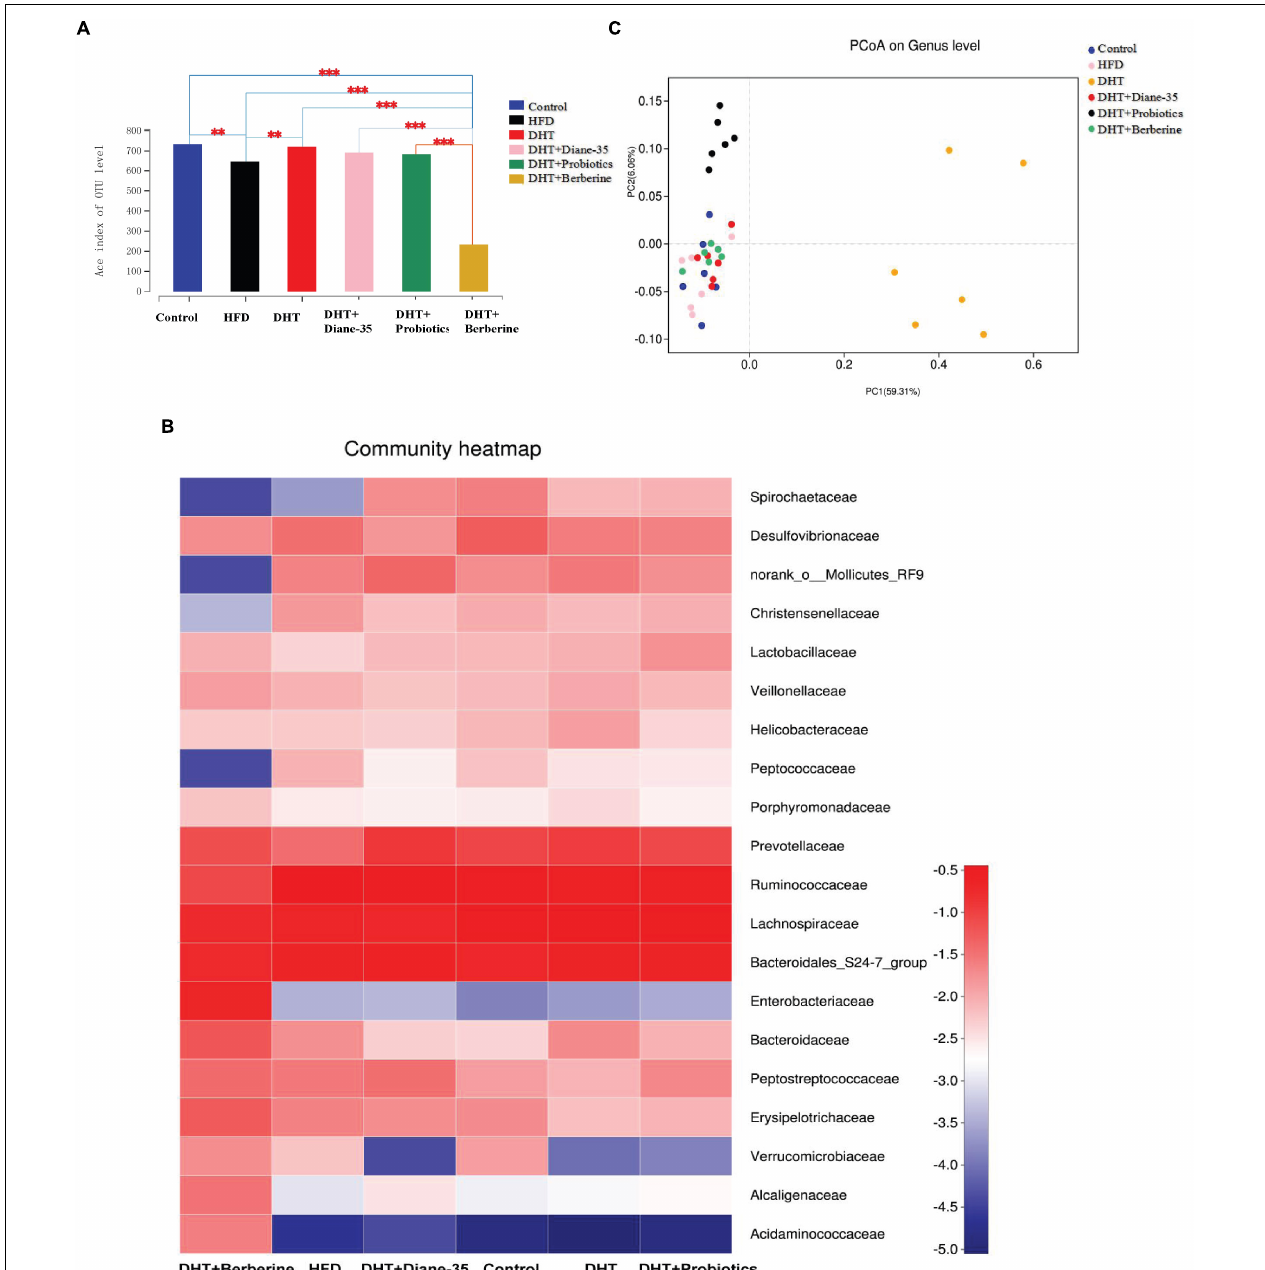
FIGURE 4 | Community composition and alpha diversity of the gut microbiota in rats. (A) The ACE index shows the microbial diversity of each group. ∗∗ P < 0.01, ∗∗∗ P < 0.001 vs. Control. (B) The value in the heatmap represents the relative abundance of the top 20 families between groups. Each tile is colored by the log value of the relative abundance percentage. Each column in the heatmap represents a group, and each row represents a family-level taxon. (C) Principal coordinate analysis (PCoA) clustering according to similarity of gut microbiota composition in the samples. The DHT + Berberine group had the lowest diversity of gut microbiota, which clustered differently from the other